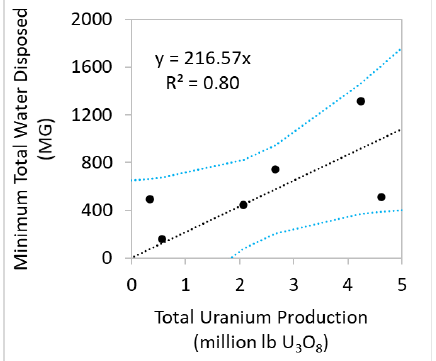
Figure 9. Minimum total volume of water disposed as a function of uranium produced (as lb U 3 O 8 ) for the six ISR operations listed in Table A1. Compiled data used to construct these graphs as well as associated references are publicly available online [18]. Note: MG = million gallons. Black line is the linear trend line and blue lines are the 95 percent confidence intervals.